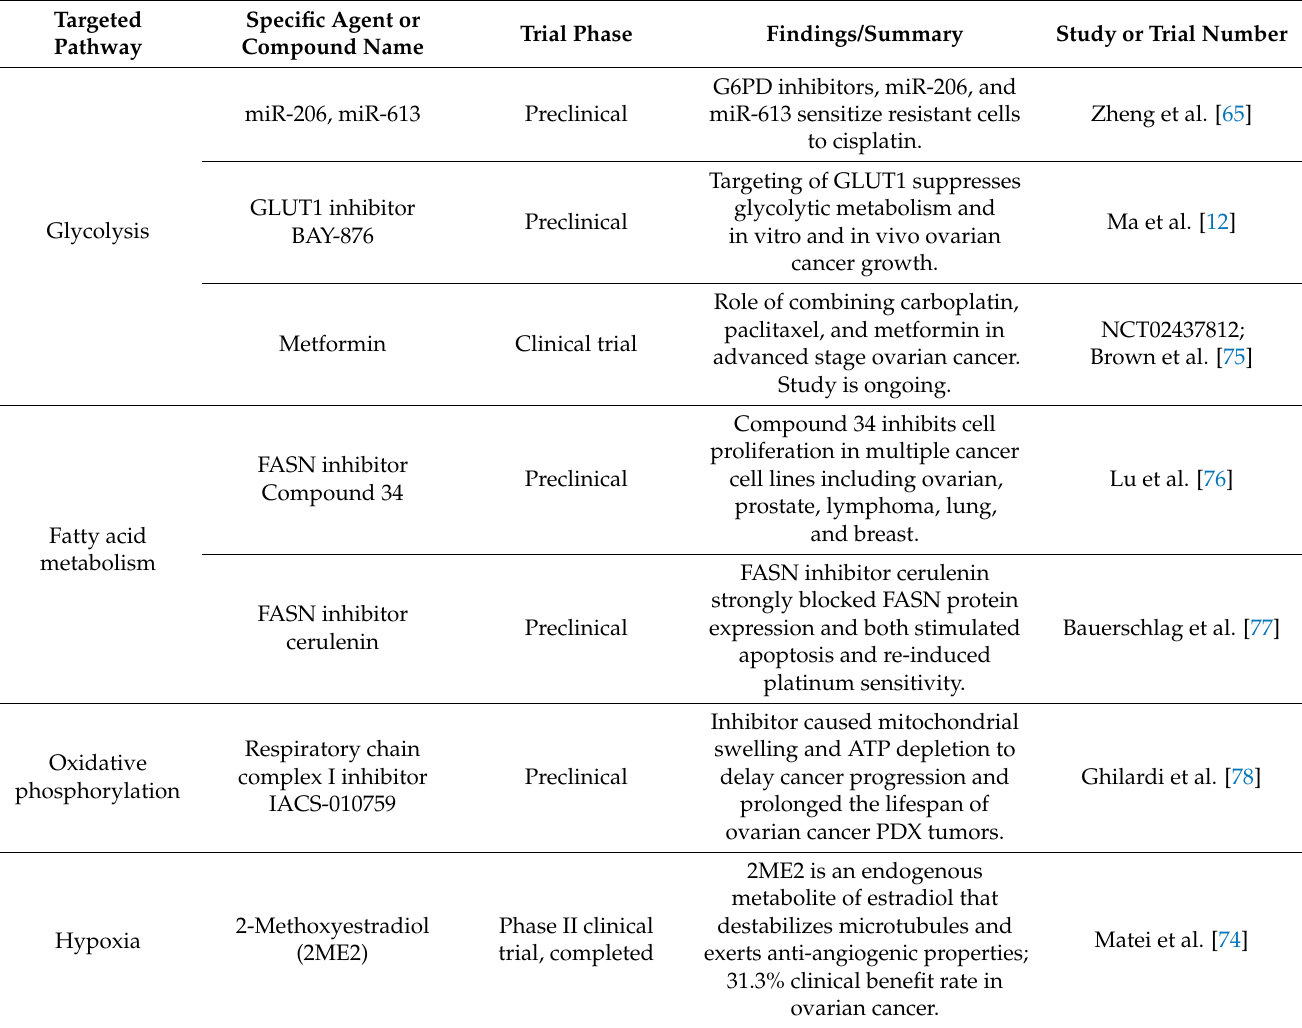
Table 1. Inhibitors targeting the ovarian cancer metabolism network in preclinical models and clinical